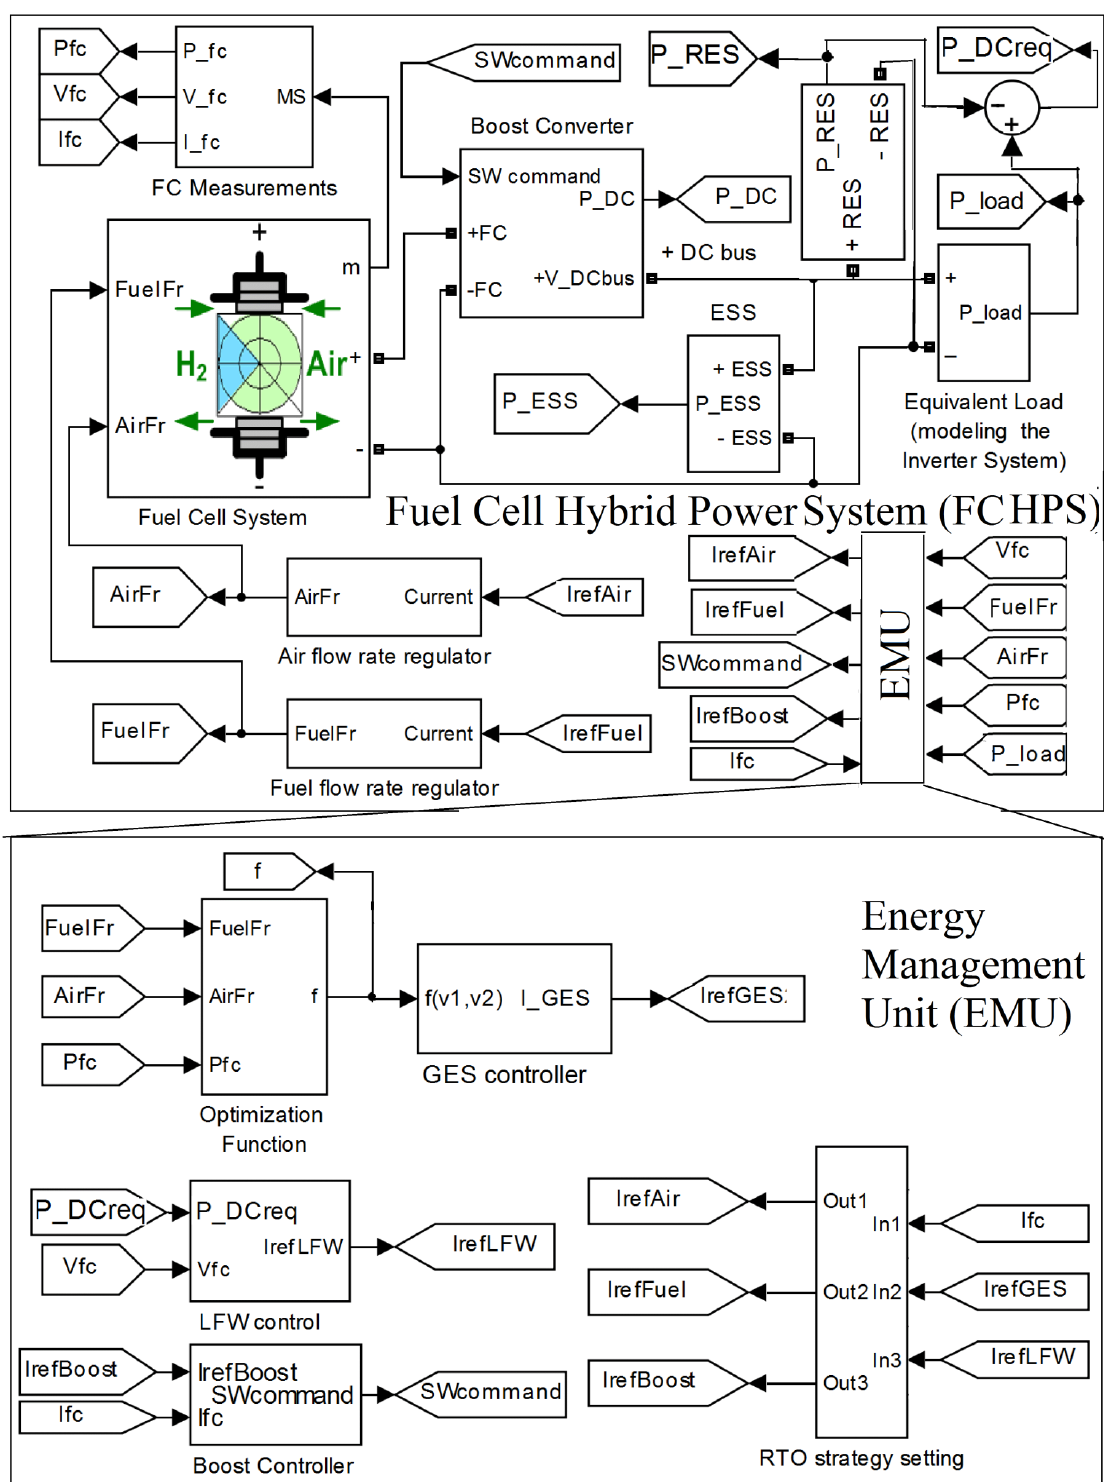
Figure 3. The FC HPS and EMU.